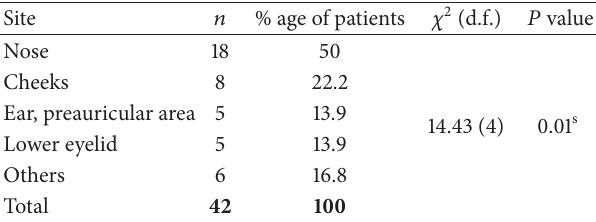
Table 5: Distribution of BCC according to site. Table 6: Morphological types of